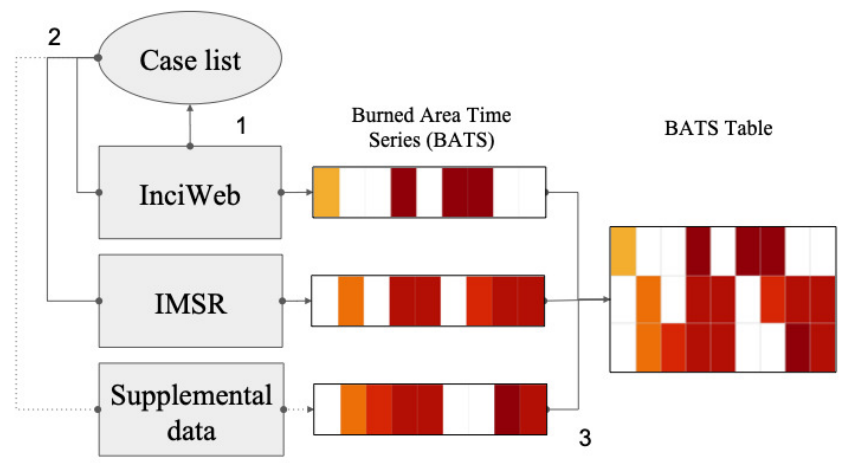
Figure 1. Graphical depiction of three-step workflow of data collection protocol. (1) a case list of wildfires that are to have data collected is produced from InciWeb. (2) burned area time series, represented here as a colored grid, are produced for all wildfires in the case list. (3) the burned area time series are combined into a single table. Increasingly red colors in the grid represent increases in reported fire size and white colors represent missing data. Numbers represent step number of